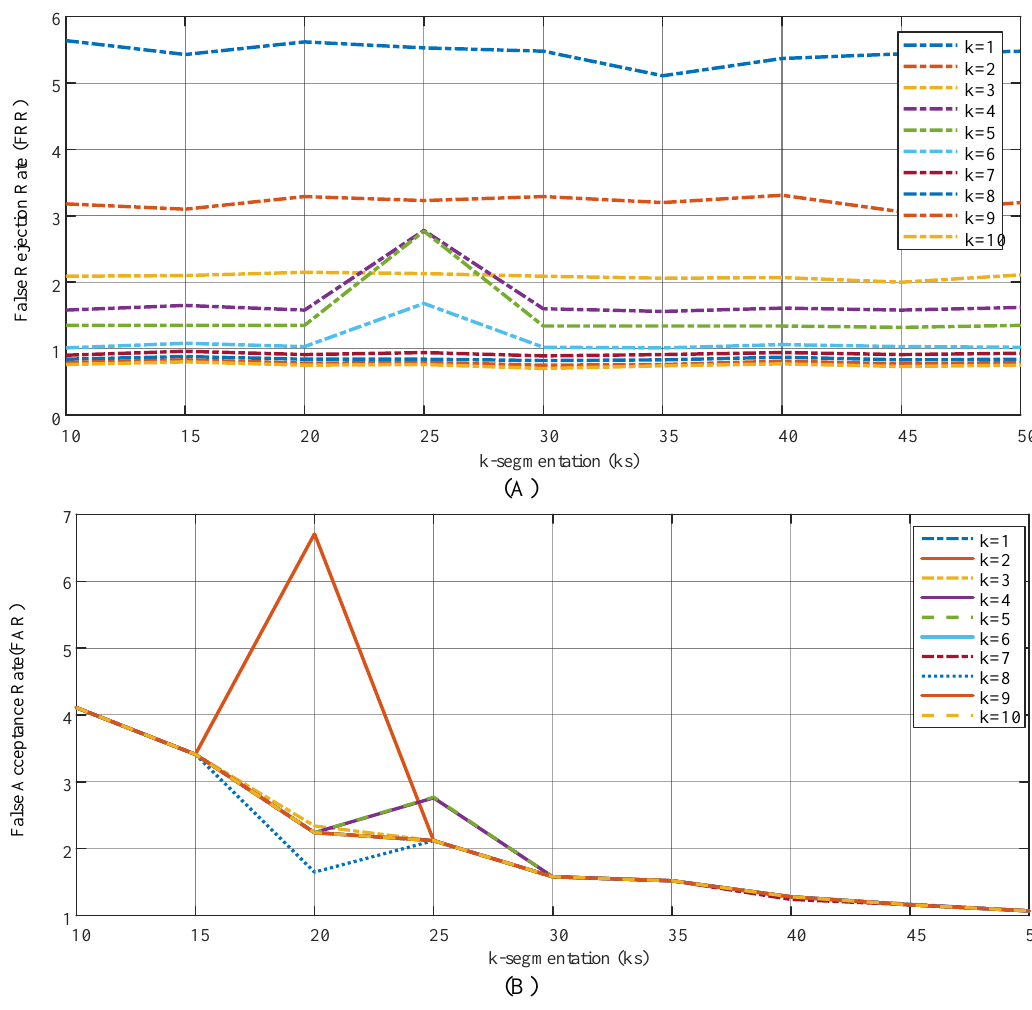
Figure 6. FRR (A) and FAR (B) diagrams in terms of different values of k_seg for different k values for the 18-channel